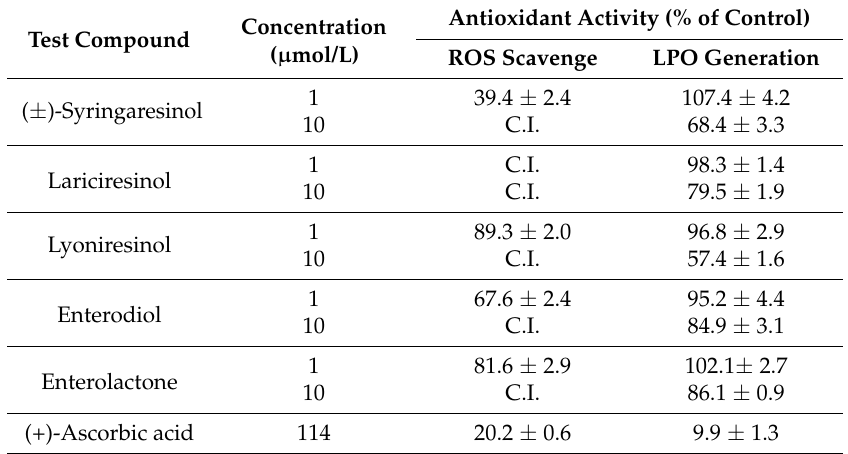
Table 4. Antioxidant activity of blood-absorbed lignans derived from